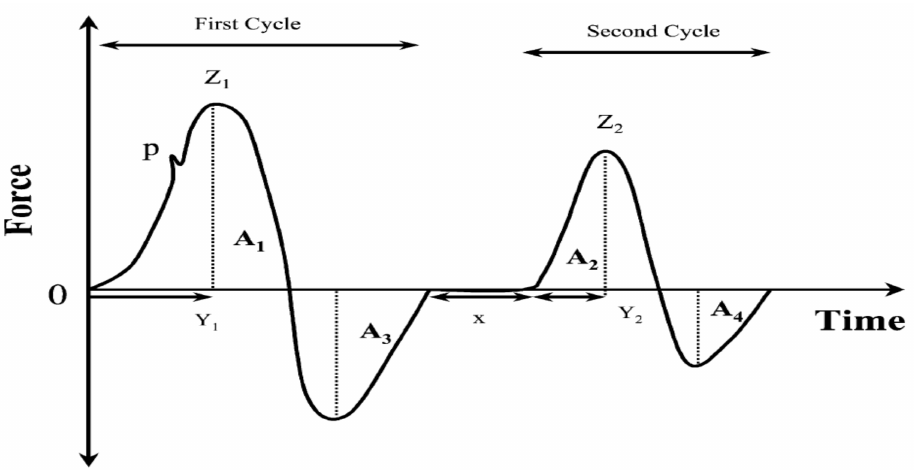
Figure 1. Generalized instrumental texture profile curve modified from Szczesniak [25]. A 1 : positive force area during first compression; A 2 : positive force area during second compression; A 3 : negative force area during first compression; A 4 : negative force area during second compression; Z 1 : height of the maximum force during first compression; Z 2 : height of the maximum force during second compression; Y 1 : time of maxime force during first compression; Y 2 : time of maxime force during second compression; x: time between the first and second